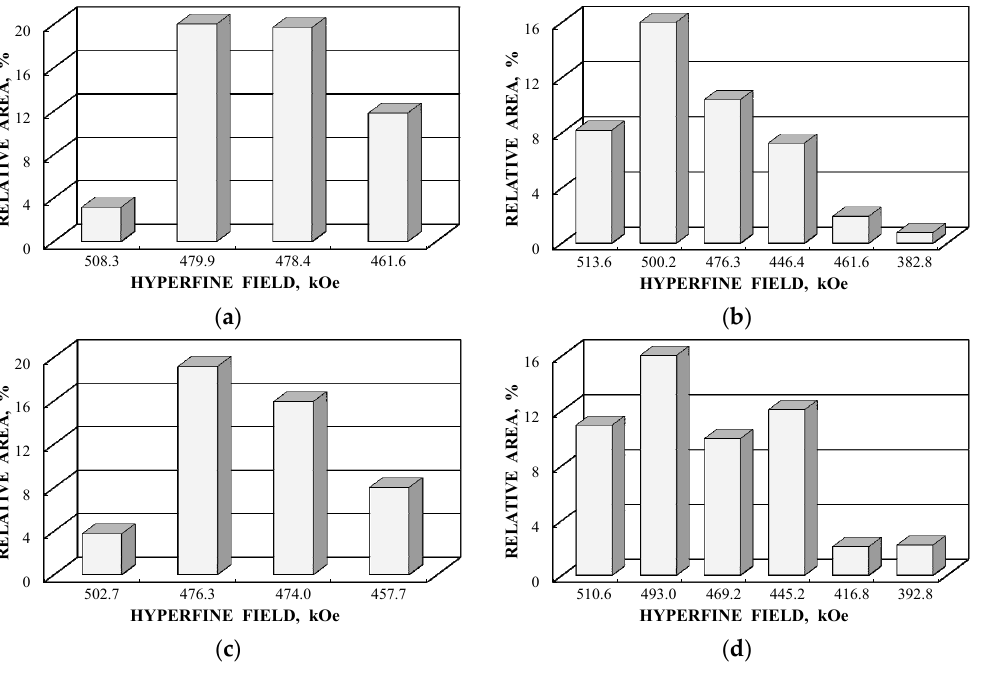
Figure 63. Histograms of the relative areas of variation for the magnetic sextets with a decrease in H eff at the 57 Fe nuclei resulting from the different numbers of Cu 2+ cation in the Fe 2+ local microen ‐ vironments in both tetrahedral ( a , c ) and octahedral ( b , d ) sites in CuFe 2 O 4 nanoparticles ( a , b ) and the